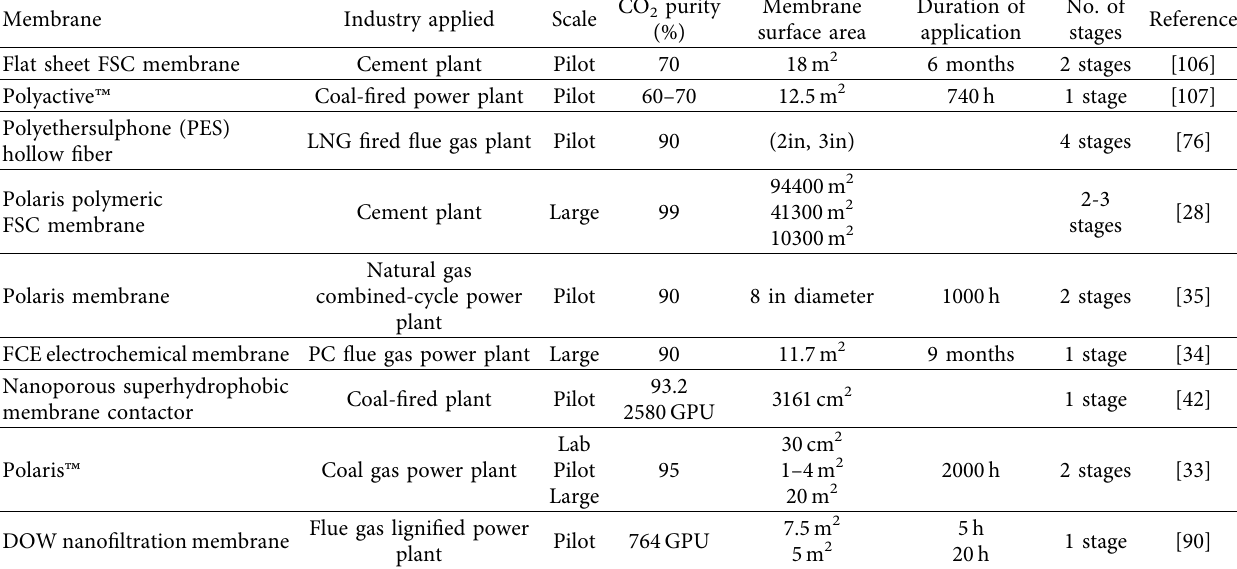
Table 2: Summary of pilot and industrial scale used